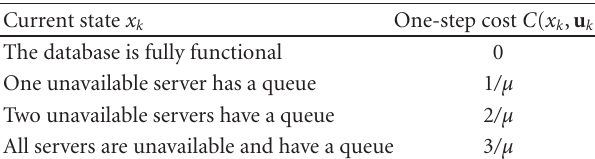
Table 2: Discounted service rate with service demand considera- tion. Current state x